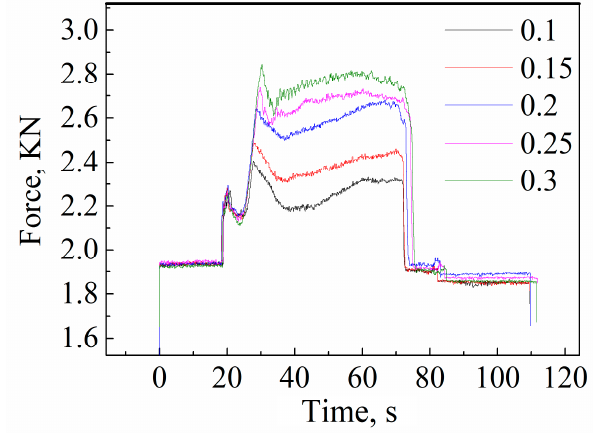
Figure 7. Relationship between axial force and the plunge depth of the shoulder.